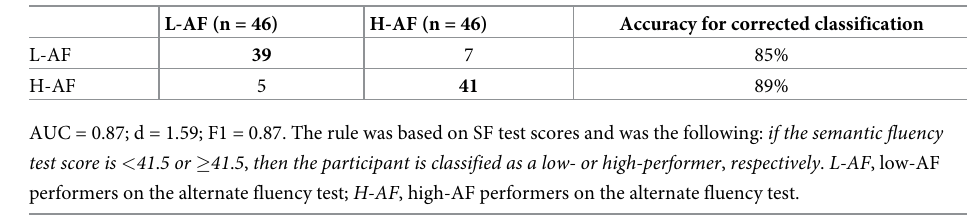
Table 4. Confusion matrix with the best performing single decision rule with oneR using 10-fold cross-validation.